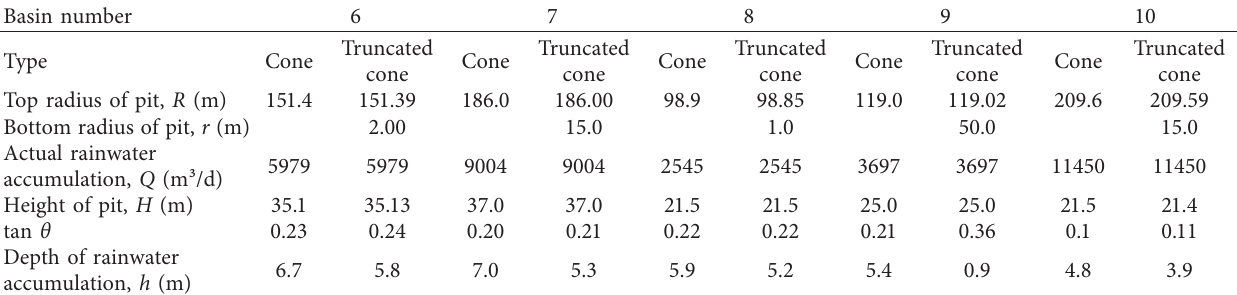
Table 8: Calculation results based on geometric models.